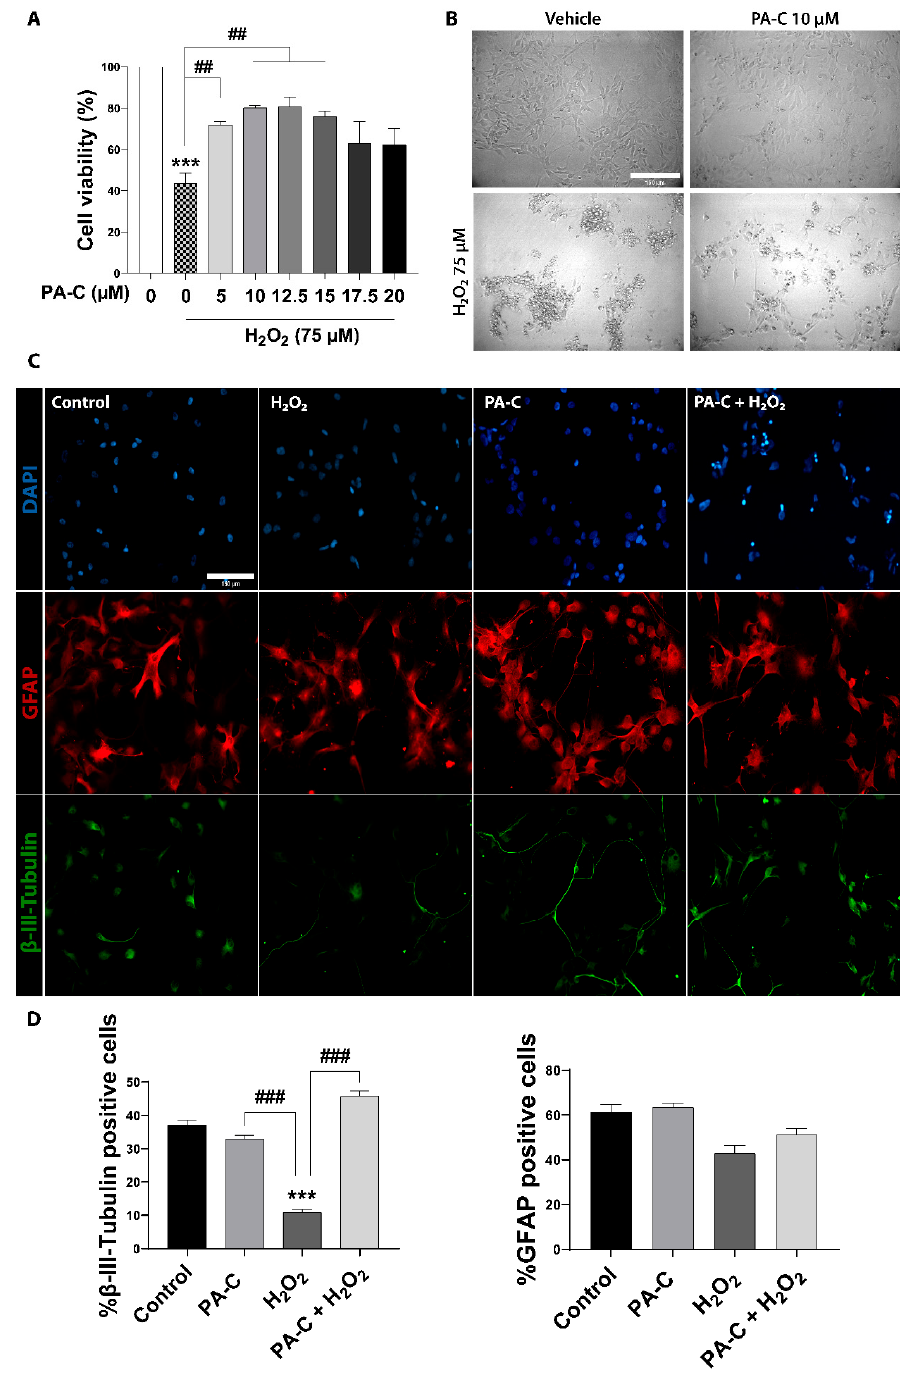
Figure 3. Neuroprotective effect of PA-C pre-treatment following peroxide-induced cytotoxicity in iPSC-NSC. ( A ). Effect of PA-C pre-treatment (5, 10, 12.5, 15, 17.5, and 20 µ M) on iPSC-NSC viability following a 24 h incubation with 75 µ M H 2 O 2 . MTS viability values represented as a percentage of vehicle-treated control cells. Data expressed as mean ± S.E.M. of three independent experiments determined by one-way ANOVA multiple comparison tests (*** p < 0.0001 vs. Control; ## p < 0.01 as indicated). ( B ). Representative bright-field images of iPSC-NSC morphology after PA-C pre-treatment and H 2 O 2 treatment (scale bar = 150 µ m). ( C ). Representative immunofluorescence staining of β -III-Tubulin (green), GFAP (red), and DAPI (blue) of iPSC-NSC pre-treated for 30 min with 10 µ M PA-C and then incubated with 75 µ M H 2 O 2 for 24 h. Scale bar = 150 µ m. ( D ). Quantitative analysis of the ratio of β -III-Tubulin cells and GFAP cells shown as a percentage of total DAPI from immunostaining. Data expressed as mean ± S.E.M. from three independent experiments as determined by one-way ANOVA with Tukey’s multiple comparison test (*** p < 0.001 vs. Control; ### p < 0.001 as